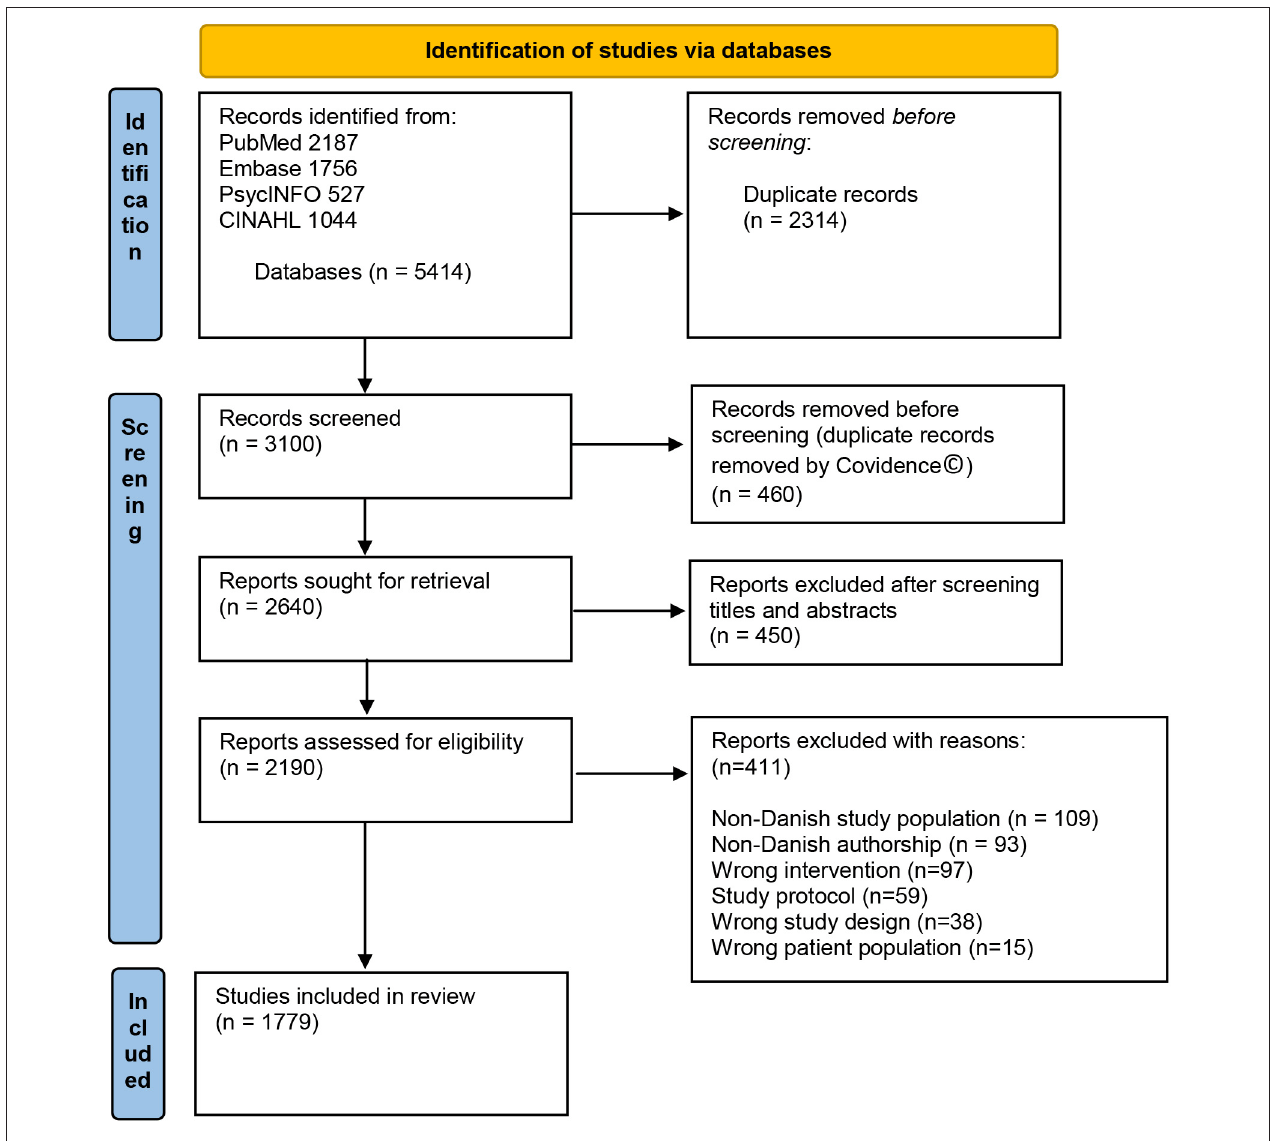
FIGURE 1 | Flow diagram of studies. Modified from Page et al.